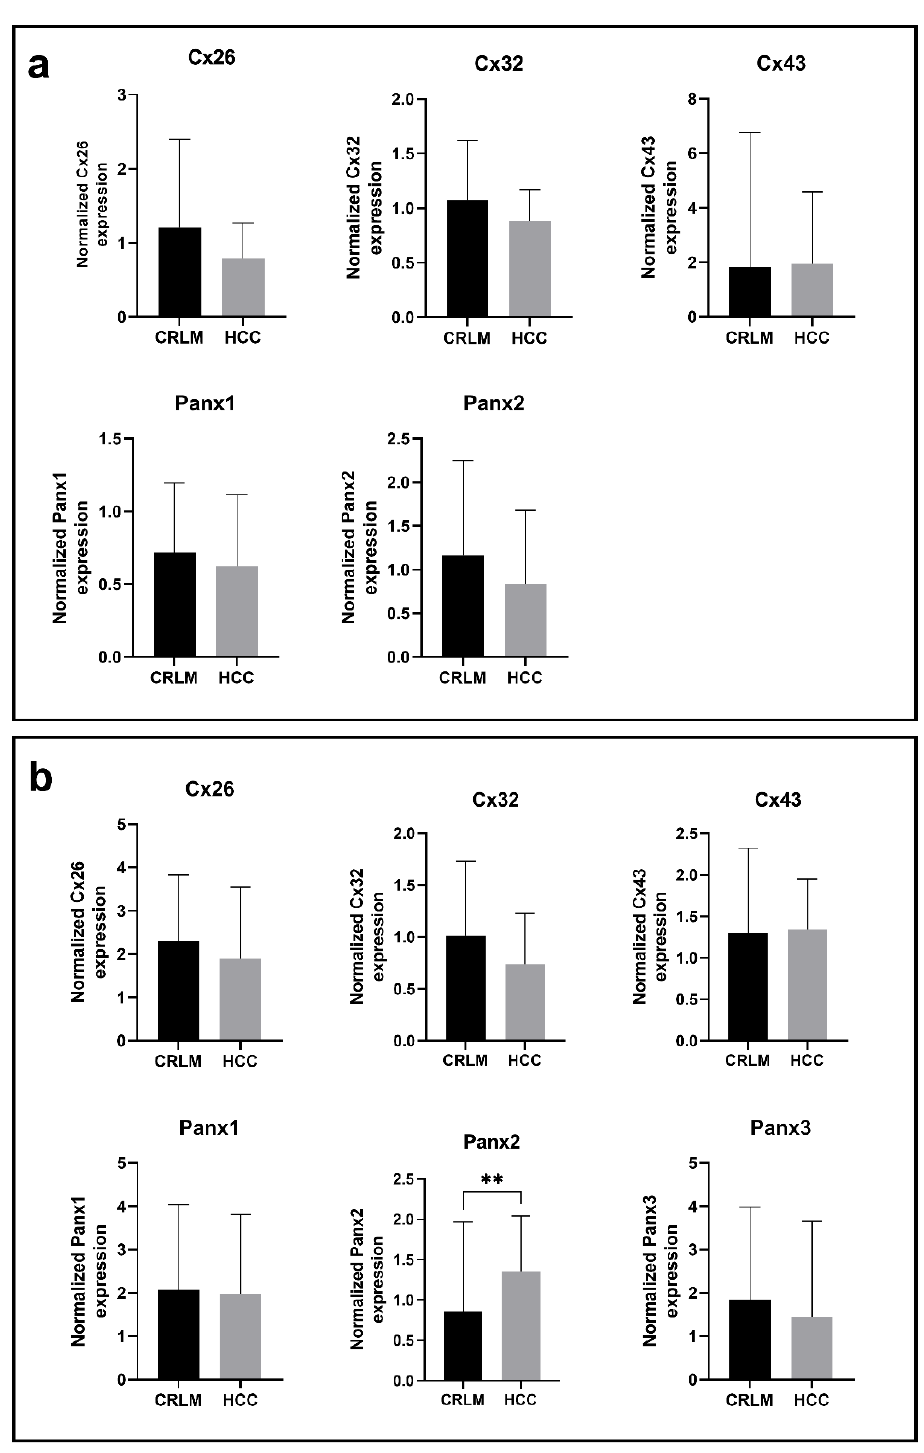
Figure 2: Cx and Panx gene (a) and protein (b) expression in CRLM and HCC samples. RT-qPCR analysis ( a ) and immunoblot analysis ( b ) of Cx26, Cx32, Cx43, Panx1, Panx2 and Panx3 was per- formed. Relative gene expression compared to a pooled sample was calculated with the Pfaffl method (Pfaffl, 2001). Protein levels were normalized to the total protein loading and expressed as a ratio to a pooled sample. CRLM samples (RT-qPCR: N = 42, n = 2; immunoblot: N = 43, n = 1) and HCC samples (RT-qPCR: N = 10, n = 2; immunoblot: N = 12, n = 1) were compared with a Mann-Whitney test or unpaired t-test depending on the normality of the data distribution. Graphs display data as mean + SD with ** p ≤